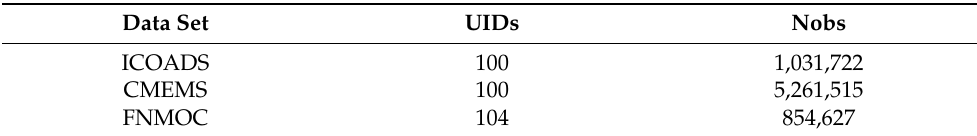
Table 4. The number of unique IDs and Nobs of TMs in three data sets. Data Set